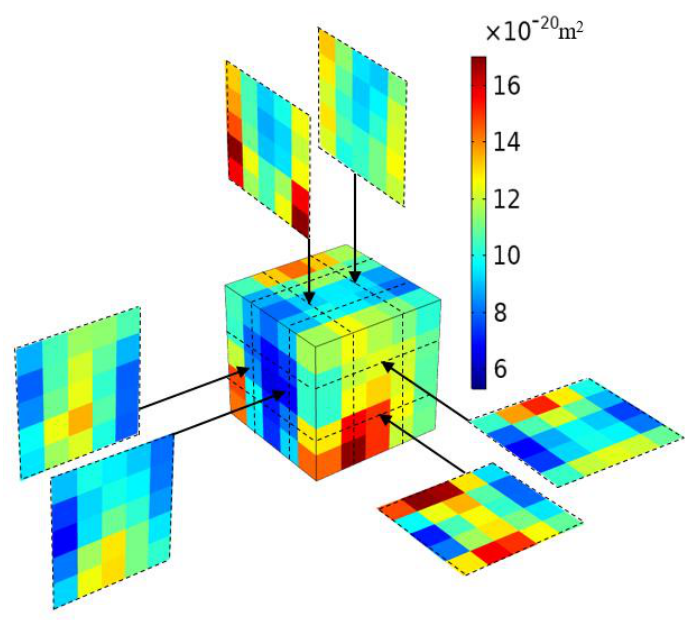
Figure 16. Spatial distribution of permeability within the cuboidal sample of Lac du Bonnet granite. ( Higher surface permeability records).